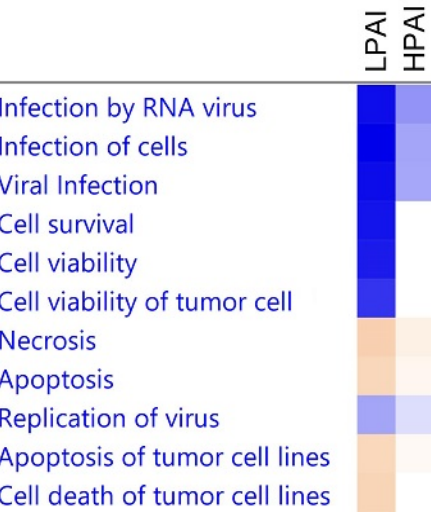
Figure 7. A comparison of biological activities differentially regulated upon LPAI or HPAI challenge. Comparison as determined by IPA software. DEGs with p < 0.05 and FC > 1.5 were used in the analysis. Shades of blue indicate down-regulation and shades of orange up-regulation.